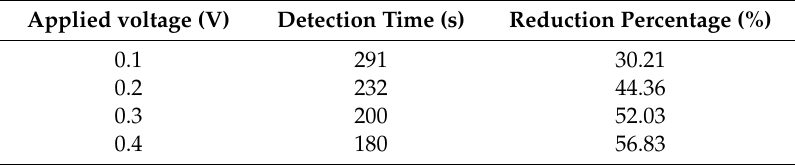
Figure 5. Effect of various voltages on the C-reactive protein (CRP) binding reaction. Table 2. Response time for C-reactive protein (CRP) binding reaction and percentage reduction.